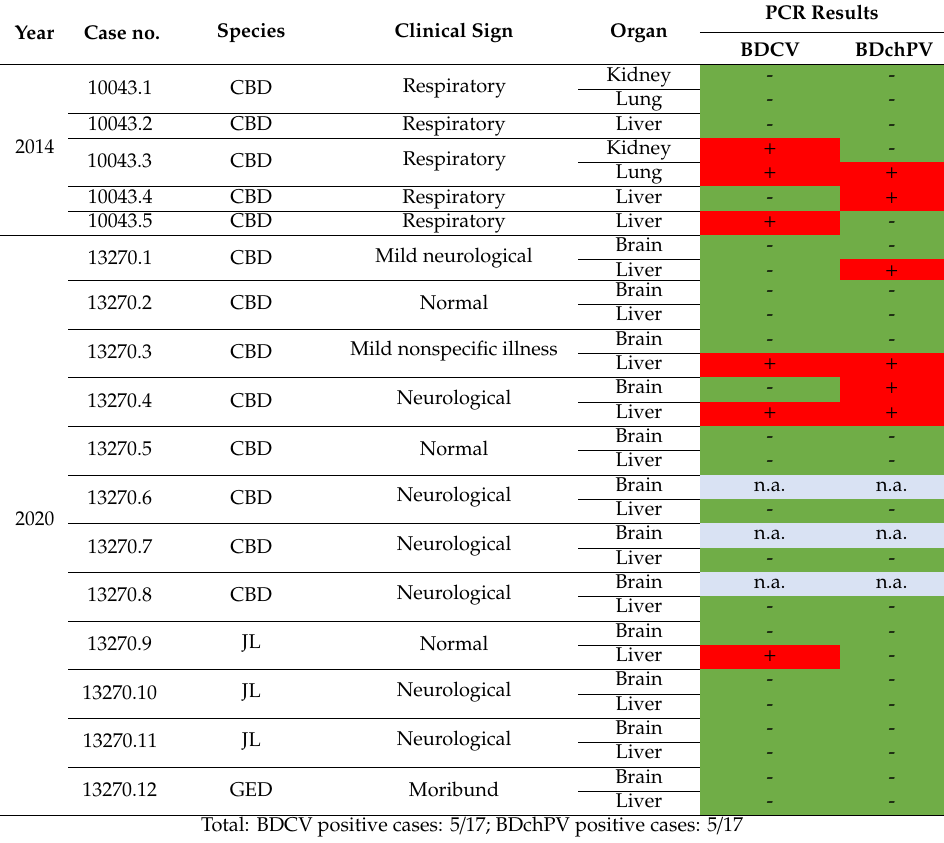
Table 3. PCR testing of captive reptiles from the 2014 and 2020